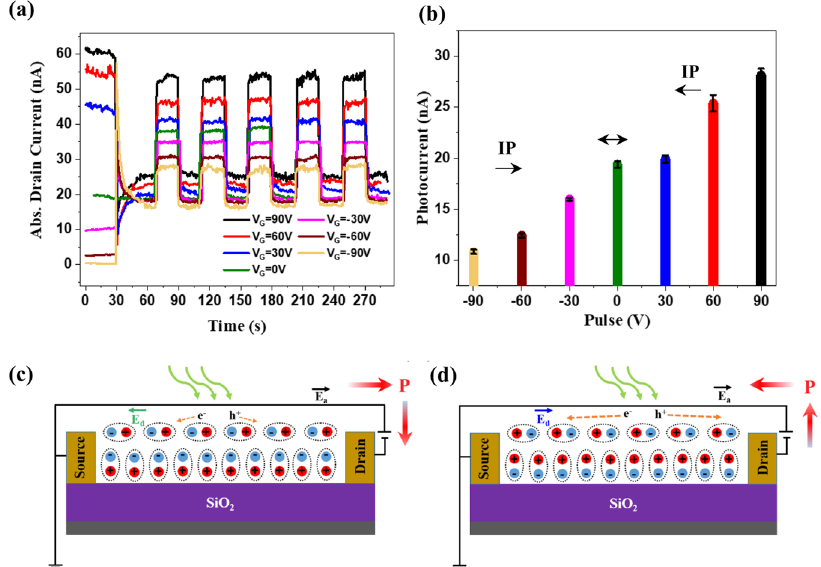
Fig. 5 Photoresponse modulation. a Temporal response of photocurrent in α -In 2 Se 3 for various gate pulses. Gate pulses were applied for 30 s after which the gate was withdrawn. The measurements were performed with zero applied gate potential and drain voltage of − 2 V thereafter. b Photorecurrent as a function of the withdrawn gate voltage pulse. Error bars comprise the standard deviation (STD) for each current level measured over time of light exposure. c , d Schematic illustrations describing the origin for the variable photoresponsivity following the application of negative and positive gate bias,